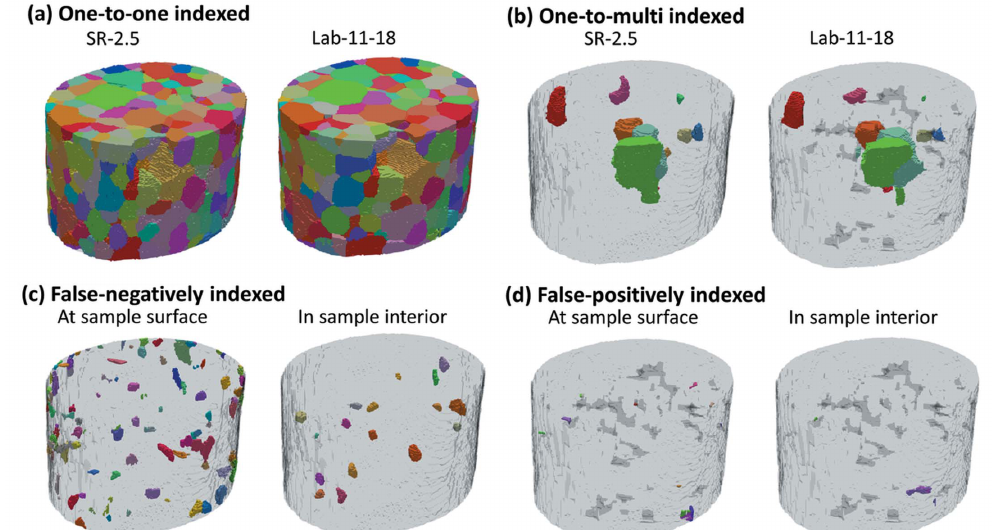
Figure 4 Visualization of the correspondence between indexed grains in the SR-2.5 and Lab-11-18 datasets. ( a ) One-to-one indexed grains, ( b ) one-to-multi indexed grains, ( c ) false-negatively indexed grains seen in SR-2.5 dataset (but not in the Lab-11-18 dataset) that are at the sample surface or located in the sample interior and ( d ) false-positively indexed grains seen in the Lab-11-18 dataset that are at the sample surface or located in the sample interior.